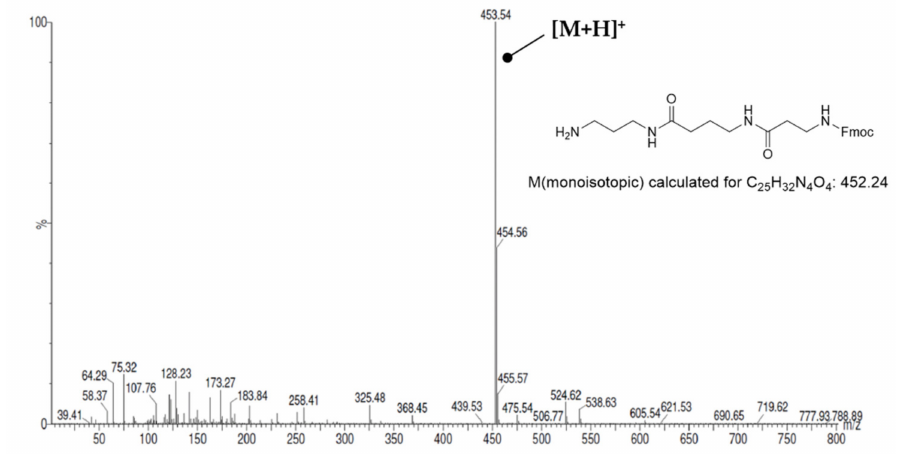
Figure 2. ESI(+) mass spectrum of N 1 -Fmoc-3,8-dioxospermine ( III